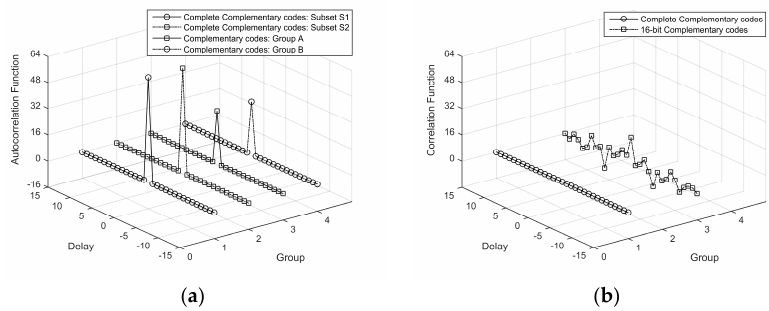
Figure 3. Analysis of {4, 4, 16} CCC and 16-bit complementary code: ( a ) Autocorrelation function ( b ) Cross correlation function.